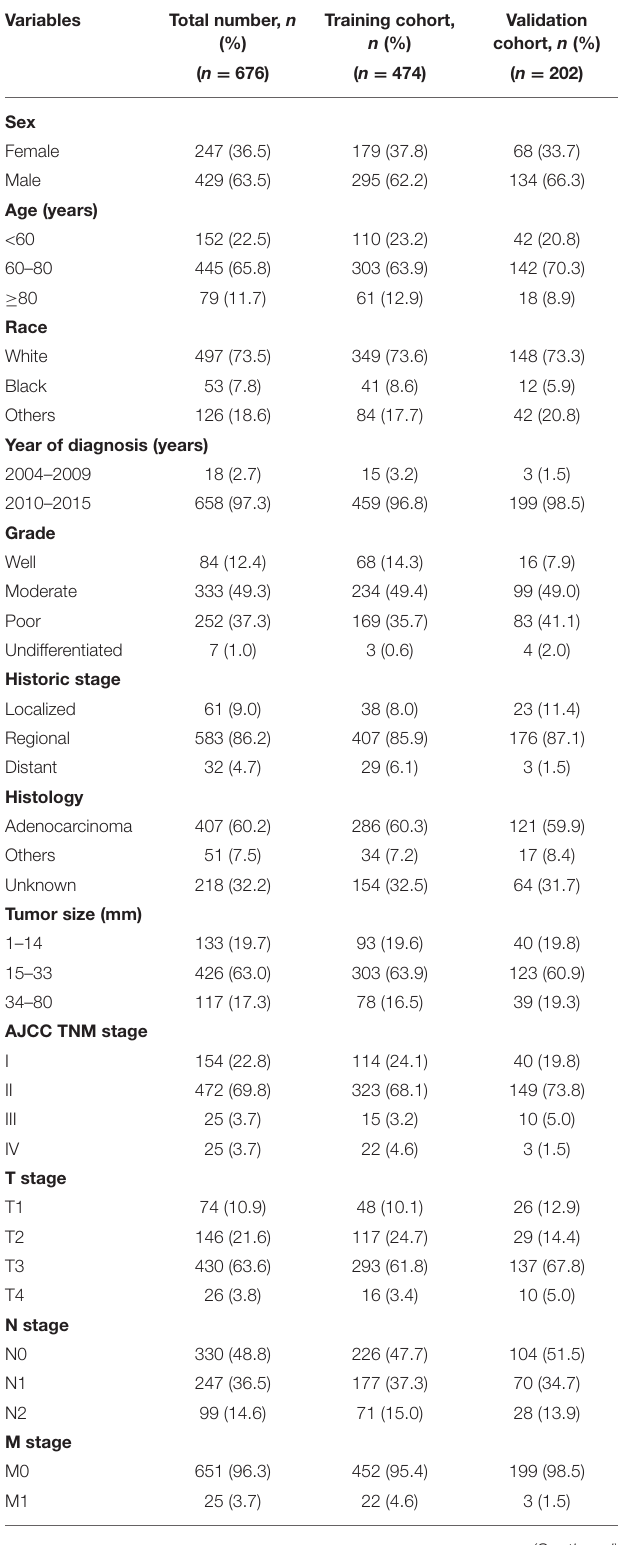
TABLE 1 | Demographics and clinicopathologic characteristics of